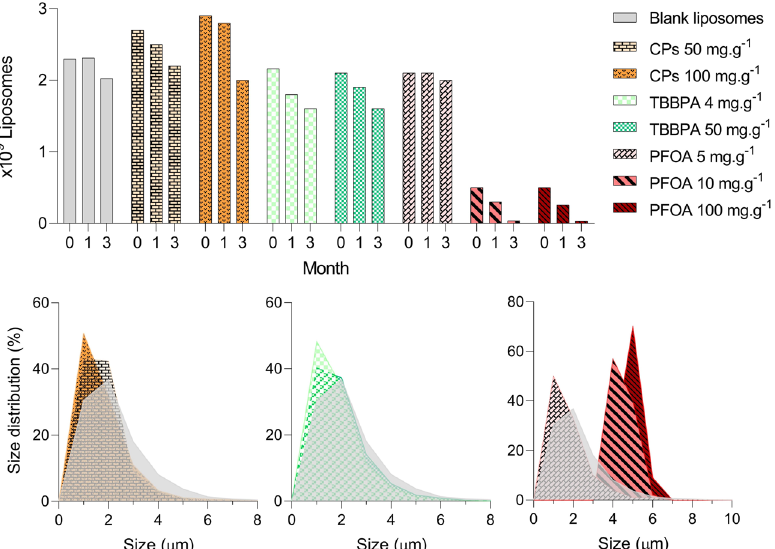
Figure 1. Physical characteristics of the blank and chemical-loaded liposomes. Stability over time (number of liposomes at 0, 1 and 3 months after preparation, top) of the blank and chemical-loaded liposomes. The number of liposomes per batch over time was used as a proxy for disintegration. Size distribution (%, 1 up to 10 μ m diameter, bottom) of the blank and chemical loaded liposomes at different concentrations: 50 and 100 mg g − 1 CPs (bottom left), 4 and 50 mg g − 1 TBBPA (bottom center) and 5 and 10 and 100 mg g − 1 PFOA (bottom